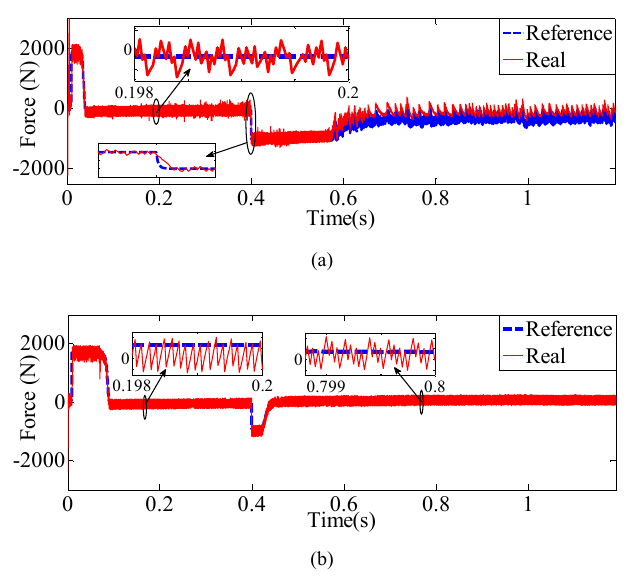
Fig. 7. The produced force of the mover (a) by using a conventional sliding mode observer (b) by using the proposed sliding mode observer.